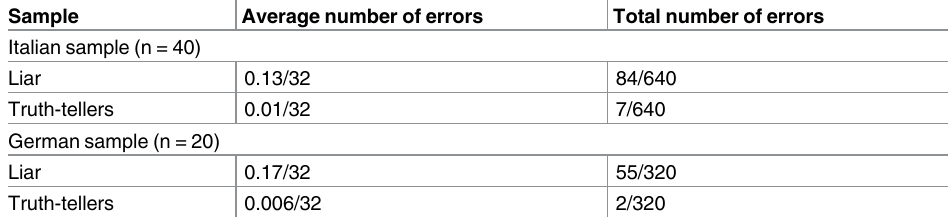
Table 8. Proportion of errors in liars and truth-tellers in the Italian and German samples.